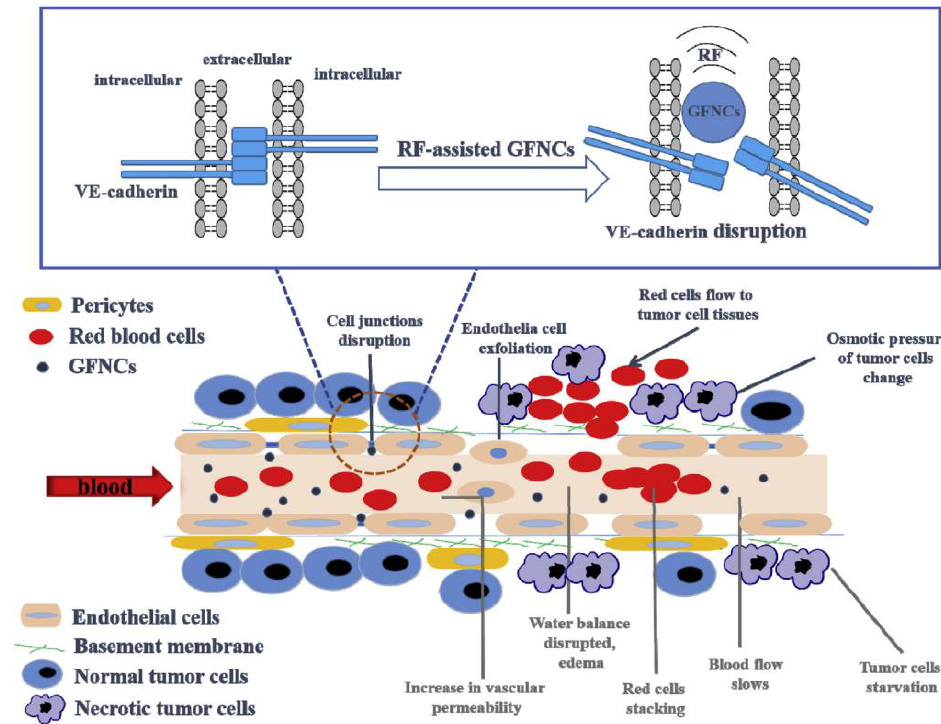
Figure 4. Schematic diagram of the mechanism of tumor vascular rupture after radiofrequency-assisted gadofullerene nanocrystal (GFNC) treatment. GFNC particles injected intravenously into tumor-bearing mice penetrate the vulnerability of tumor vascular ECs. When radiofrequency irradiation is applied, the sudden volume expansion of GFNCs can lead to the destruction of vascular endothelial cadherin at the junction of endothelial adhesion bodies of tumor vessels, thereby increasing vascular permeability and realizing the destruction of tumor vessels. Reproduced from Li and Zhen et al. [139,190] .